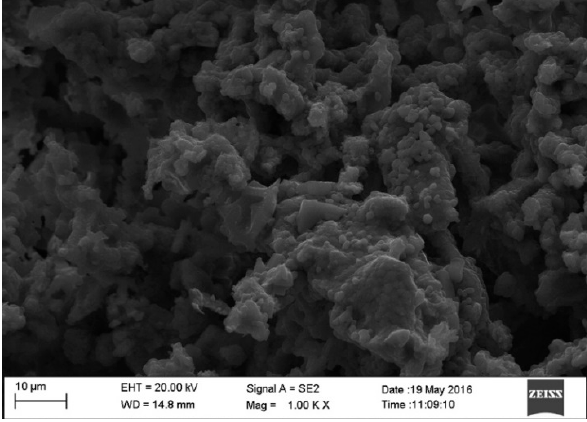
Figure 2. SEM image of calcined CPK ash at 500 °C.